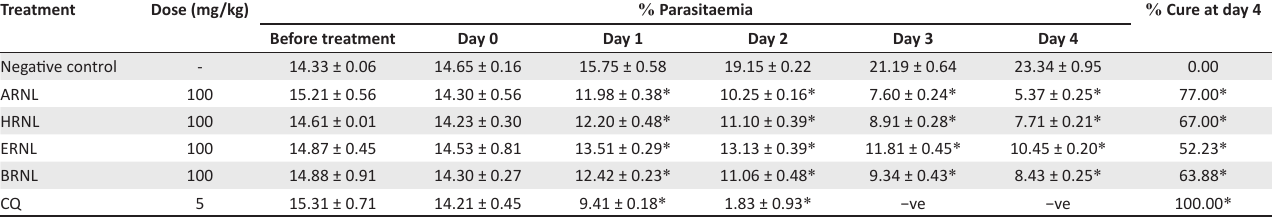
TABLE 2: Curative activity of Nauclea latifolia roots extract and fractions against Plasmodium berghei -infected mice (Rane test). Treatment Dose